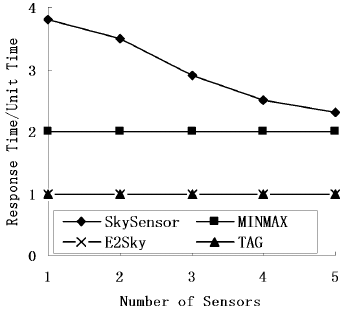
Figure 11. Response times under different numbers of sensors.